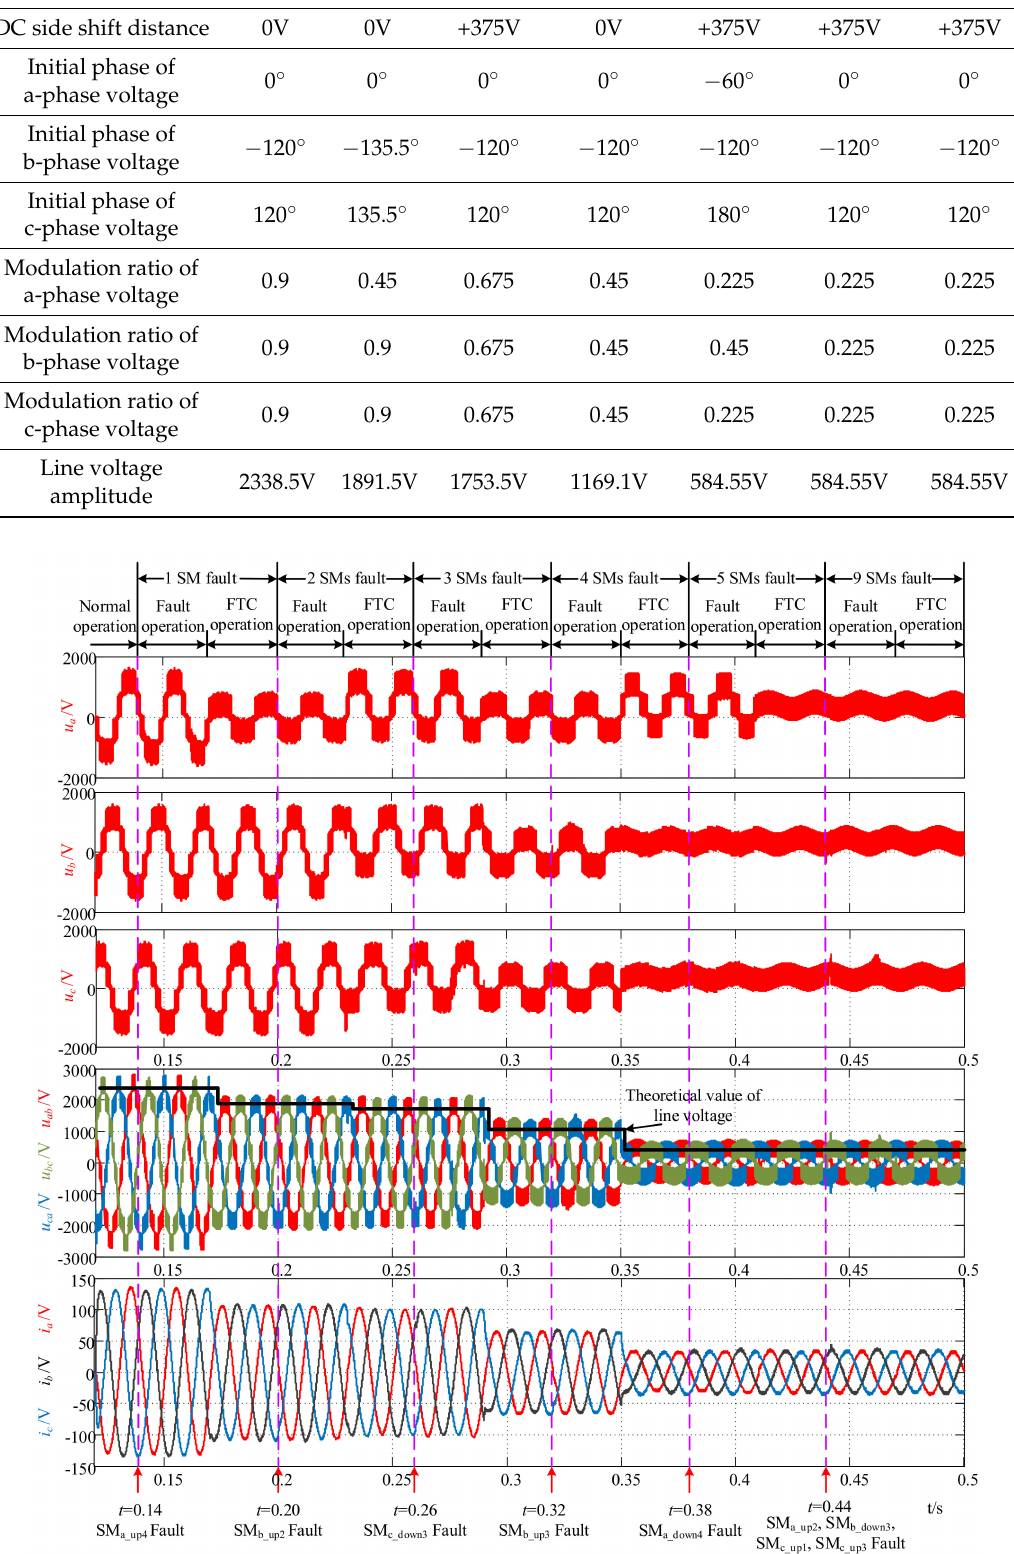
Figure 11. The waveforms of three-phase output phase voltage, line voltage, and